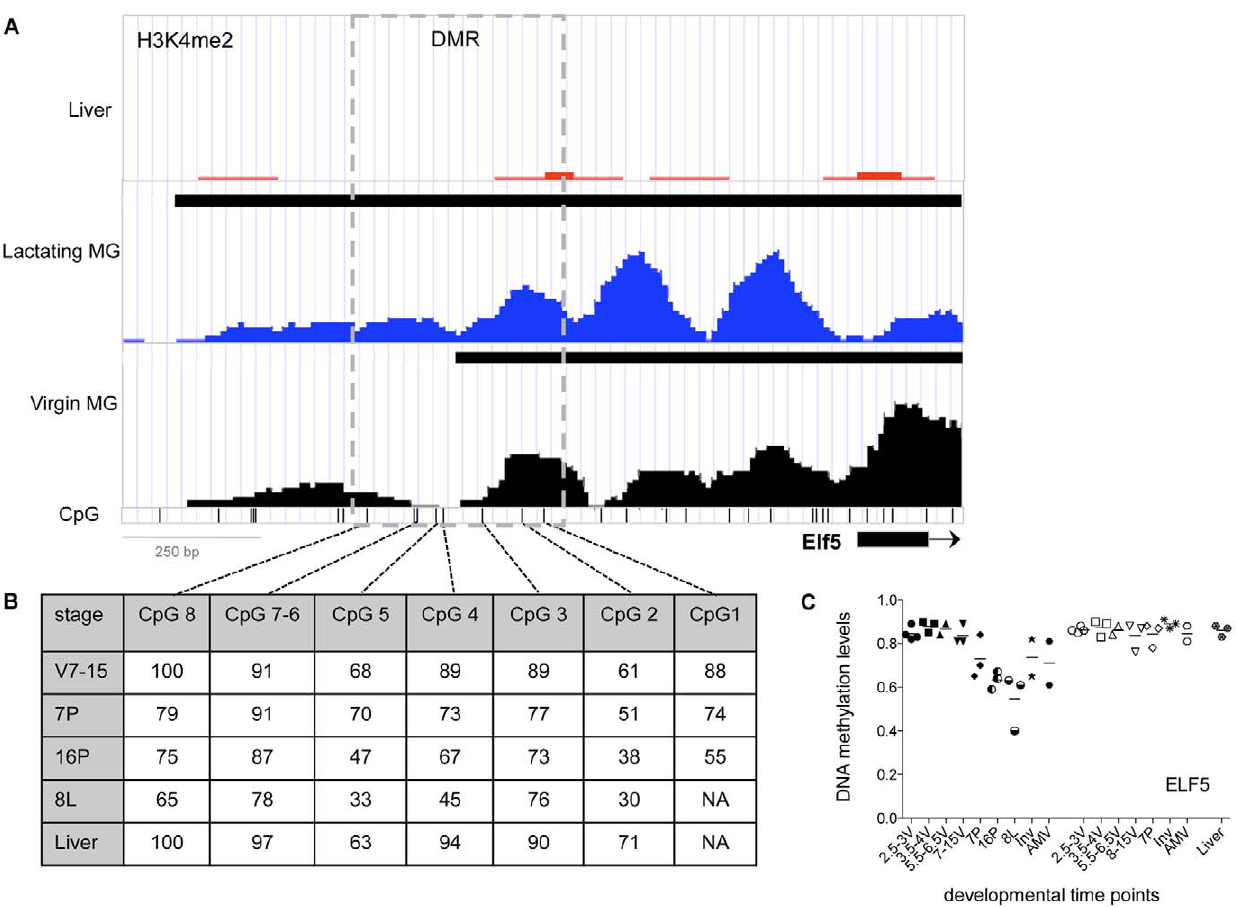
Figure 7. Summary of chromatin organization in the Elf5 region. ( A ) ChIP-seq for H3K4me2 in liver (red), lactating mammary glands (blue) and mammary epithelial cells isolated from 12 week virgin mammary glands (black). Black bars at the top of the Liver, Lactating MG, and Virgin MG panels show the H3K4me2 enriched regions identified by MACS. CpG : genomic locations of CpG sites in the 5 9 flanking region, exon1 & part of intron 1 ( 2 1418 to + 189); DMR indicates the differentially modified region analyzed. ( B ) Table: shows average levels of DNA methylation (%) at developmental stages for individual CpG sites in region analyzed by SEQUENOM mass-array. ( C ) Scatter plot of the changes in DNA methylation levels at different time points during mammary gland development and differentiation at DMR in Elf5 promoter: different developmental time points are depicted with different filled symbols. Mammary epithelial cell enriched fractions (MEC) , filled symbols: Virgin (2.5_3V: 2.5–3 week old virgin female, filled circle; 3.5–4V, 3.5–4 week old virgin, filled square; 5.5_6V: 5.5–6 week old female virgin, filled downward pointing triangle; 8_15V; 8–15 week old virgin, filled upward pointing triangle); Pregnancy (7P: 7day pregnant, filled diamond; 16P: 16 days pregnant (whole tissue), half vertically filled circle); Lactation (8L; 8 day lactation (whole tissue), half horizontally filled circle); Inv ( . 28 day after lactation) 5-pointed star; AMV: Age Matched Virgin (Virgin animal same age as . 28 day involuted animal), filled hexagonal. Non-MEC cell fraction of the mammary gland (Non-MEC, open symbols): 2.5_3: 2.5–3 week old virgin female, open circle; 3.5–4V, 3.5–4 week old virgin, open square; 5.5_6: 5.5–6 week old female virgin, open downward pointing triangle; 8_15; 8–15 Week virgin, open upward pointing triangle; Pregnancy (7P: 7day pregnant, open diamond); Inv ( . 28 day after lactation, 8 pointed star); AMV: Age Matched Virgin (Virgin animal same age as . 28 day involuted animal), open hexagonal); or Non-mammary tissue (hexagonal with star): Liver.